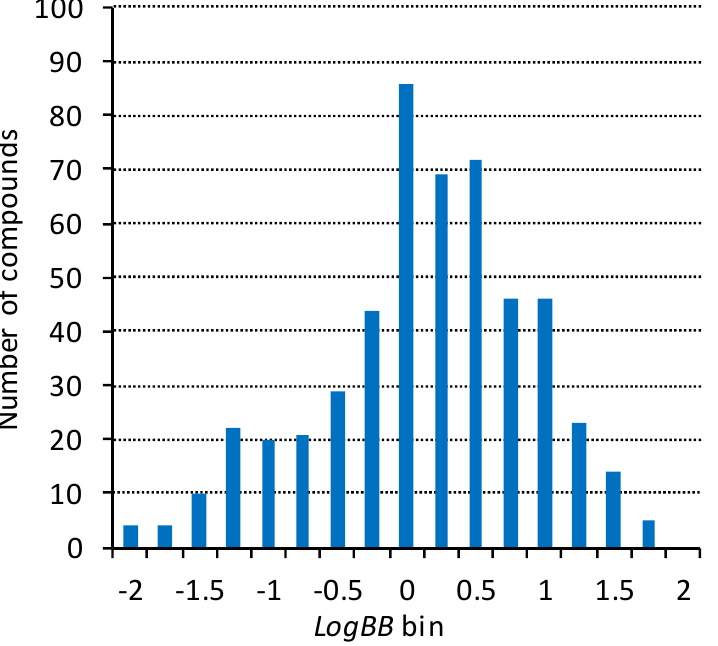
Figure 1. Distribution of the LogBB values in the modeling dataset.